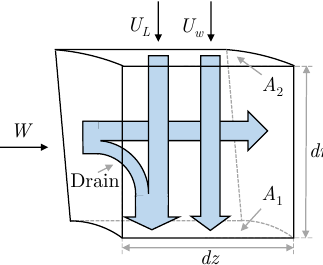
Figure 10. Flow element with blue arrows representing flow. A portion of W is converted into radial speed. The outgoing and ingoing velocities do not sum to zero as the bottom area, A 1 , and top area, A 2 , of the flow element are different. However, the ingoing and outgoing flow rates sum to zero as there is no